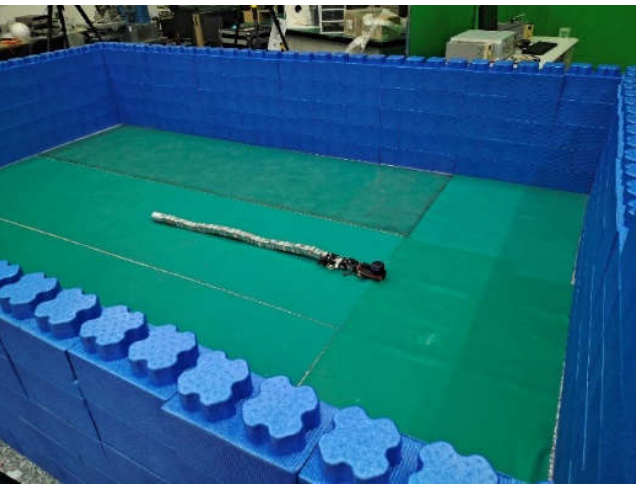
Figure 12. Experimental